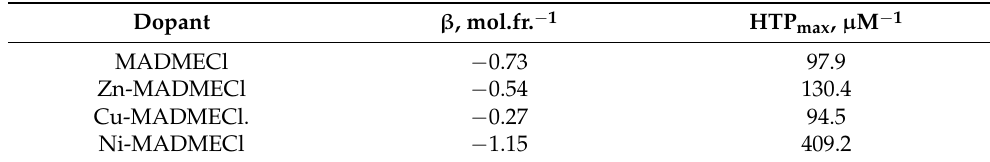
Figure 4. Effect of dopant concentration on its HTP ( a ) - ○ -MADMECl; - ● - Ni-MADMECl; ( b ) - ▲ - Zn-MADMECl; - ■ -Cu-MADMECl. Table 6. Effect of a metal on the thermal stability of the LC phase ( β = d(T NI /T° NI )/dn 2 and the maximum HTP .